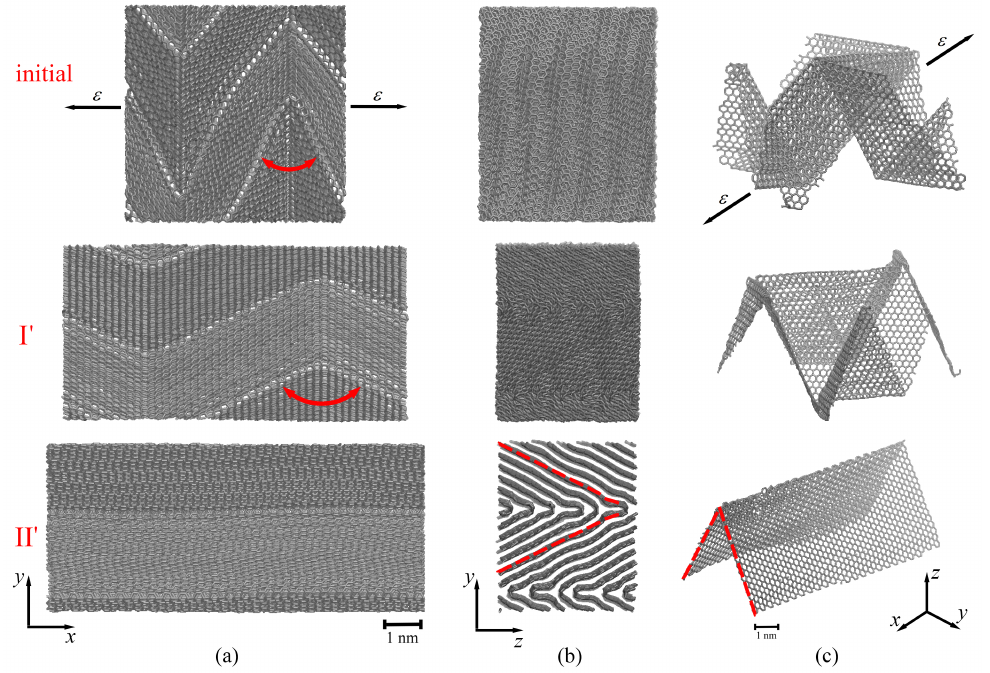
Figure 4. The snapshots of the MG in projection to the ( a ) xy -plane and ( b ) yz -plane and ( c ) snapshot of the graphene layer in perspective view at the initial state and during tension along the x -axis at critical points I’ ( ε = 0.5), II’ ( ε = 0.62). The structure after compression and before tension is labeled as “initial”. Points I’ and II’ are shown in a red solid line in Figure3. The opening angle is shown by red arrows. The tension direction is shown by black